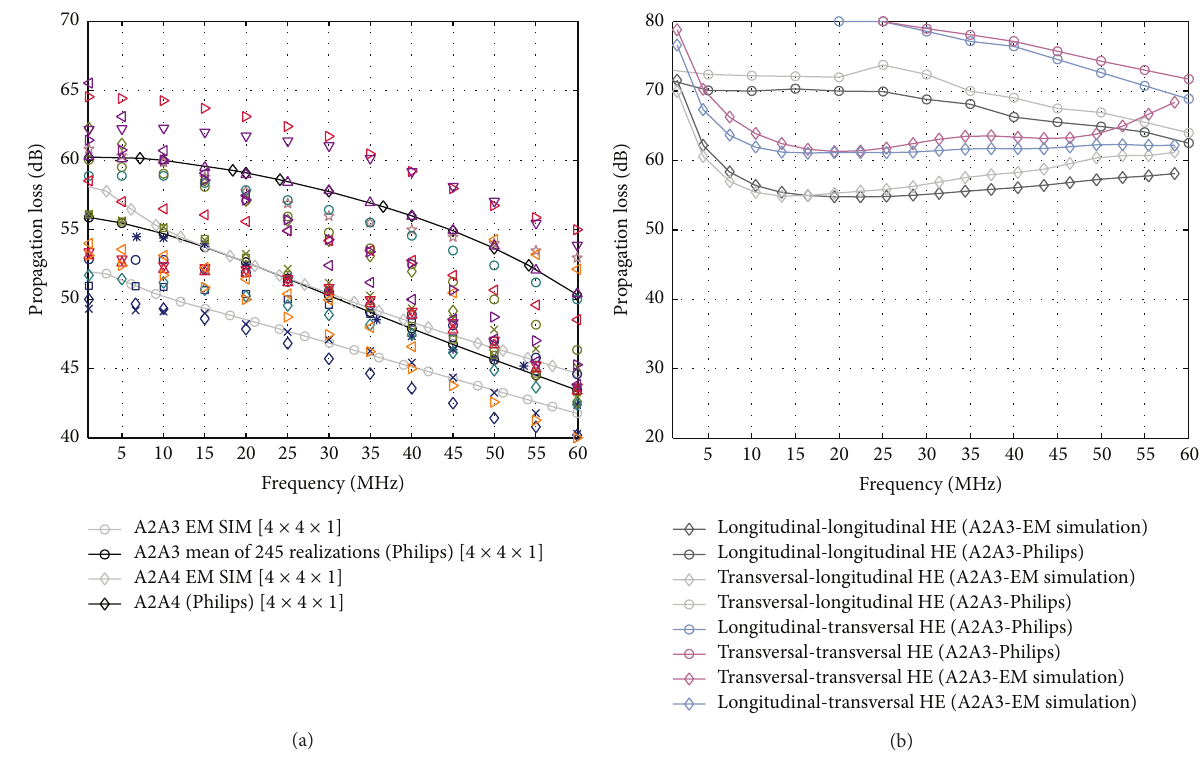
Figure 5: 3D full-wave EM simulation results compared with Philips measurement results [1, 16, 17] for the skin-only-rectangle (Sk-Rec) human body model with (a) vertical couplers [4 × 4 × 1] for A2A3 and A2A4 path lengths (the coloured symbols show variations in Philips measurements with respect to coupler dimensions, separation, construction, and body position/movements), (b) horizontal couplers [5 × 2 × 1] having different orientations for A2A3 path